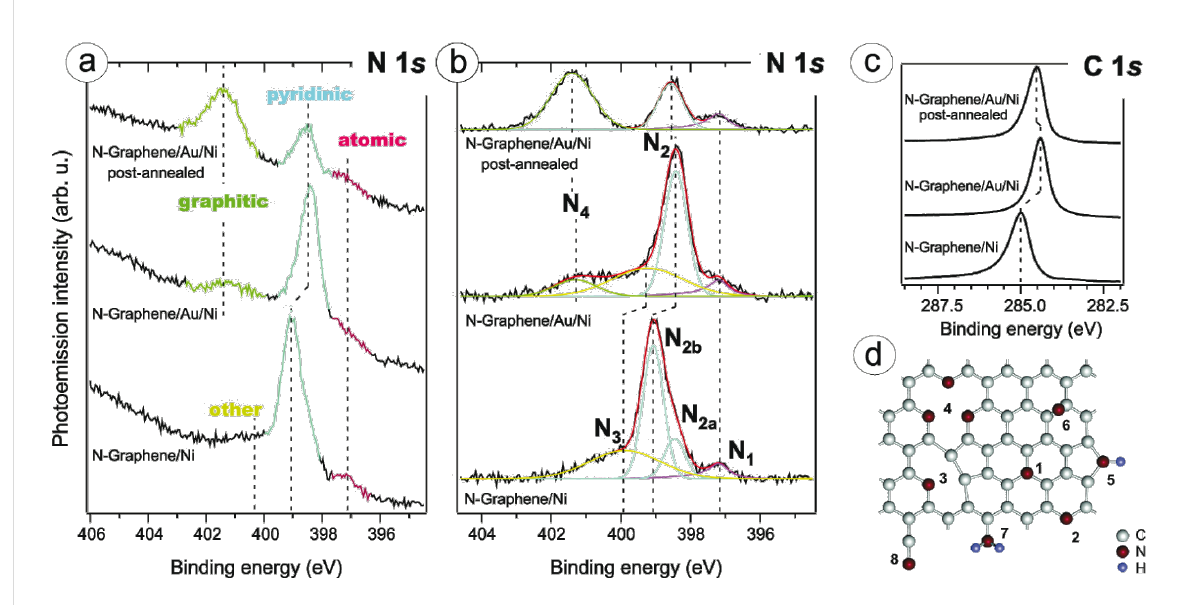
Figure 3: An XPS measurement and peak assignment of nitrogen-doped graphene prepared by chemical vapor deposition. (a–c) N 1s and C 1s spectra of N-graphene freshly prepared on nickel, intercalated by gold, and treated by post-annealing. Note the large shifts caused by interaction with the substrate in the non-intercalated spectrum. The N 1s spectra shown in (b) have been background-subtracted. In the post-annealed sample, a peak at 401.3 eV was assigned to graphitic nitrogen, and another at 398.4 eV to pyridinic N. (d) Some proposed possible configurations of graphene nitrogen impurities: (1) graphitic (substitutional) N; three varieties of pyridinic bonding: (2) edge pyridinic N, (3) single N pyridinic vacancy (1NV), and (4) triple N pyridinic vacancy (3NV); (5) pyrrole-like N, (6) interstitial N or adatom, and (7) amine or (8) nitrile groups. Adapted with permission from [127], copyright 2011 The American Chemical